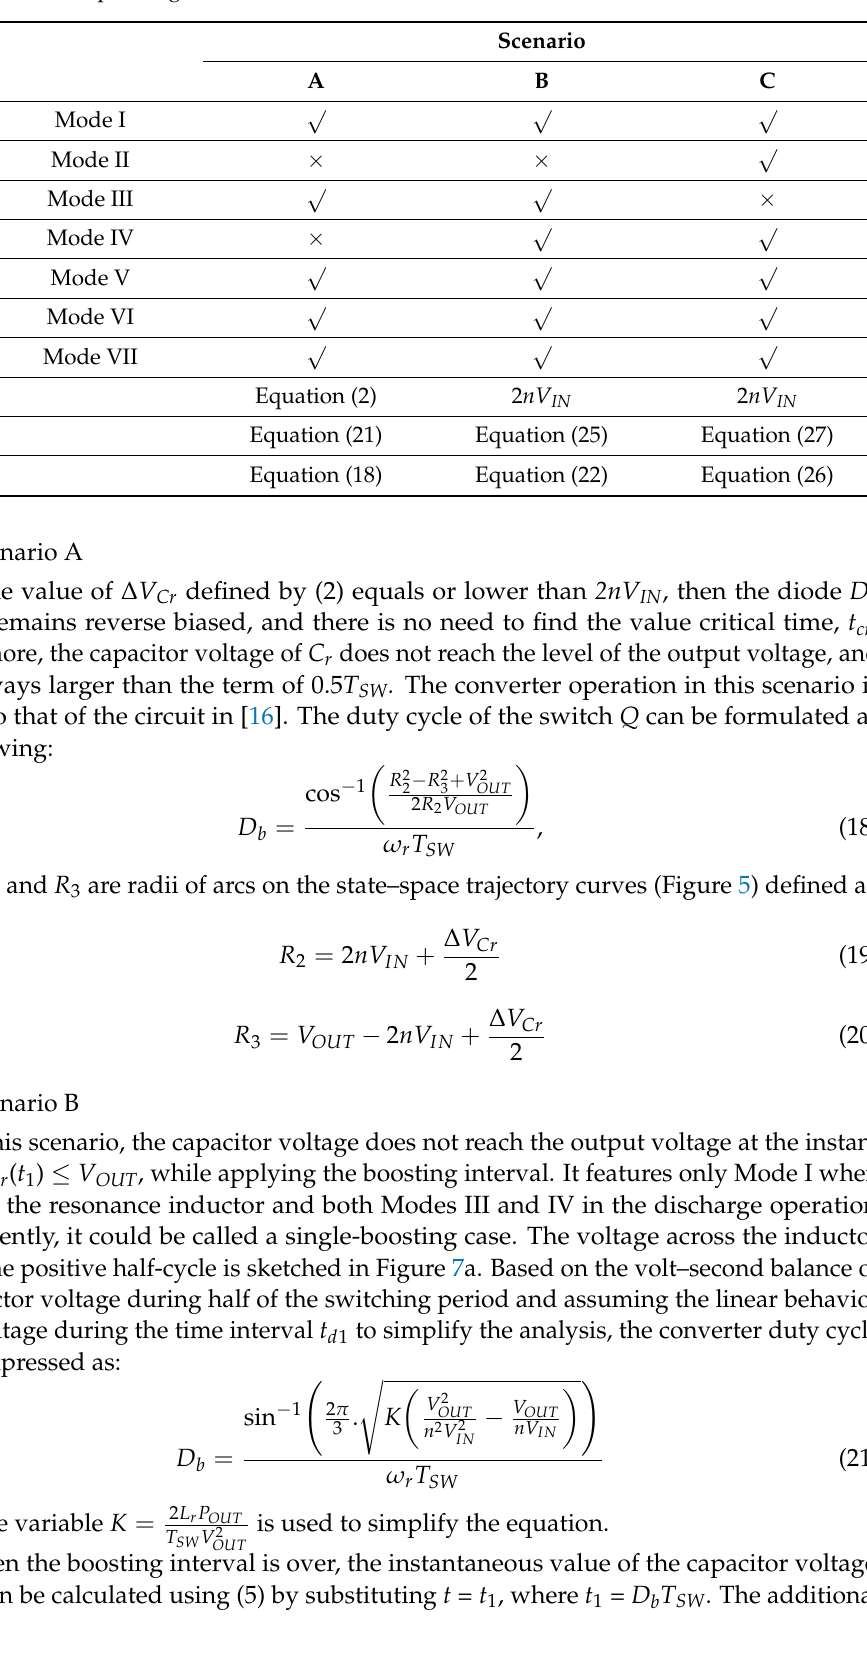
Table 1. Converter operating scenarios in the boost - SRC